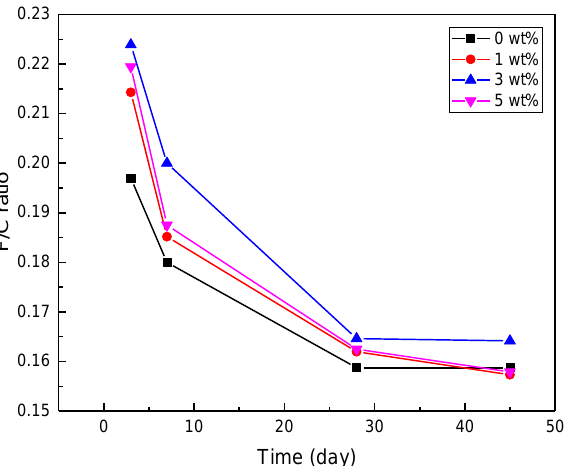
Figure 8. F/C ratio of cement pastes with different nanohybrid contents at 3, 7, 28, and 45 days.